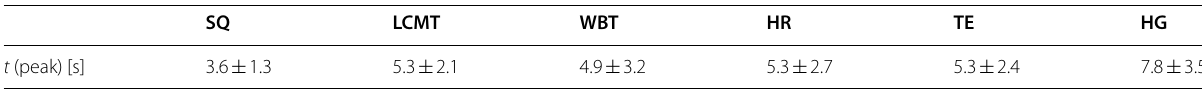
Table 2 Time to peak mean arterial pressure in various